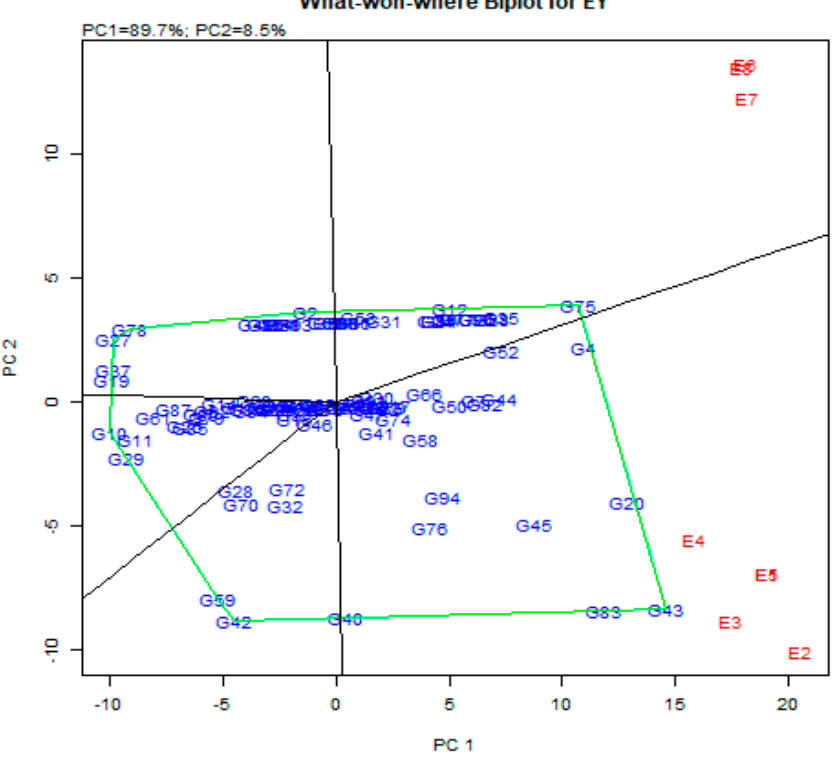
Figure 3. Polygon view of GGE (genotype plus genotype by environment interaction) biplot (which-won-where model) showing 20 elite wheat lines in irrigated and drought environment.